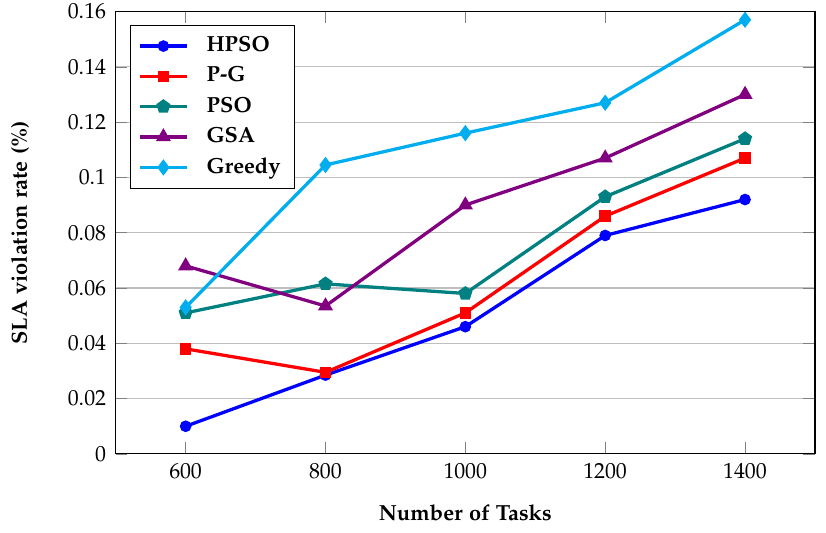
Figure 11. SLA violation rate